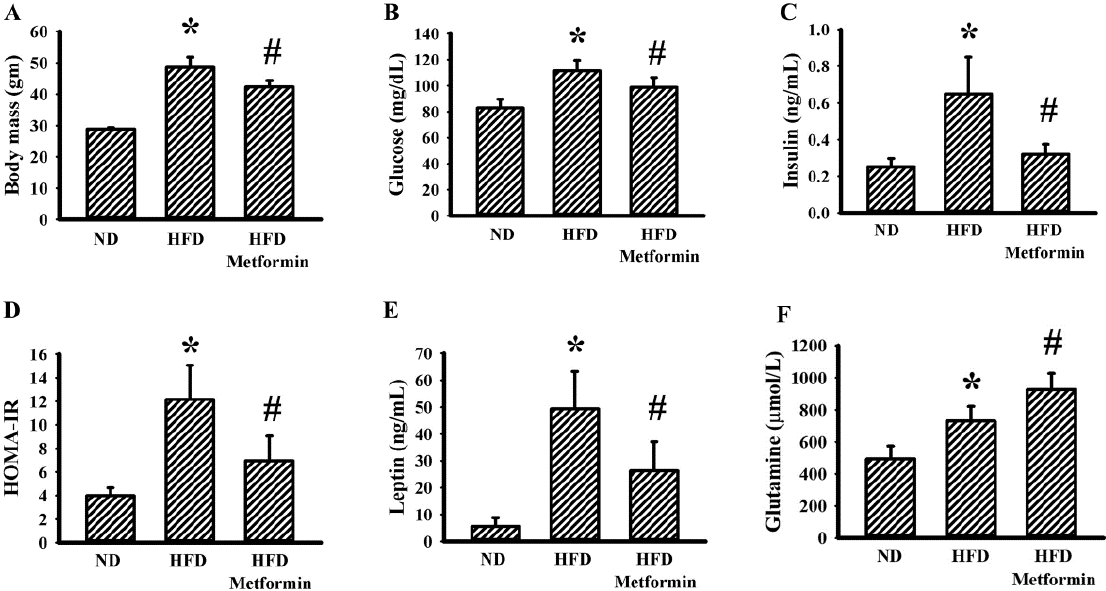
Figure 1. Metformin mitigated tumor growth in obese mice. ND-fed lean and HFD-fed obese mice were subcutaneously inoculated with LLC cells over a course of three weeks. Three days after cell implantation, ND-fed lean mice were treated daily with saline vehicle through intraperitoneal injection (ND). HFD-fed obese mice were separated into two groups receiving daily intraperitoneal injections of a saline vehicle (HFD) or metformin (50 mg/kg, HFD/Metformin) for the final 18 days. The tumor volumes were measured ( A ) and the resected tumor tissues were weighed ( B ). Representative resected tumors are shown ( B ). * p < 0.05 vs. ND and # p < 0.05 vs. HFD, n = 6.